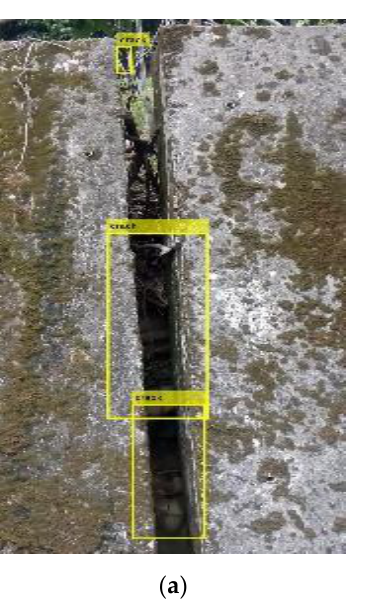
Figure 13. Dangerous crack detection result of the case ( a ) crack #1 ( b ) crack #2. (The crack size is in the yellow box, and the data are given in Tables 1 and 2.)